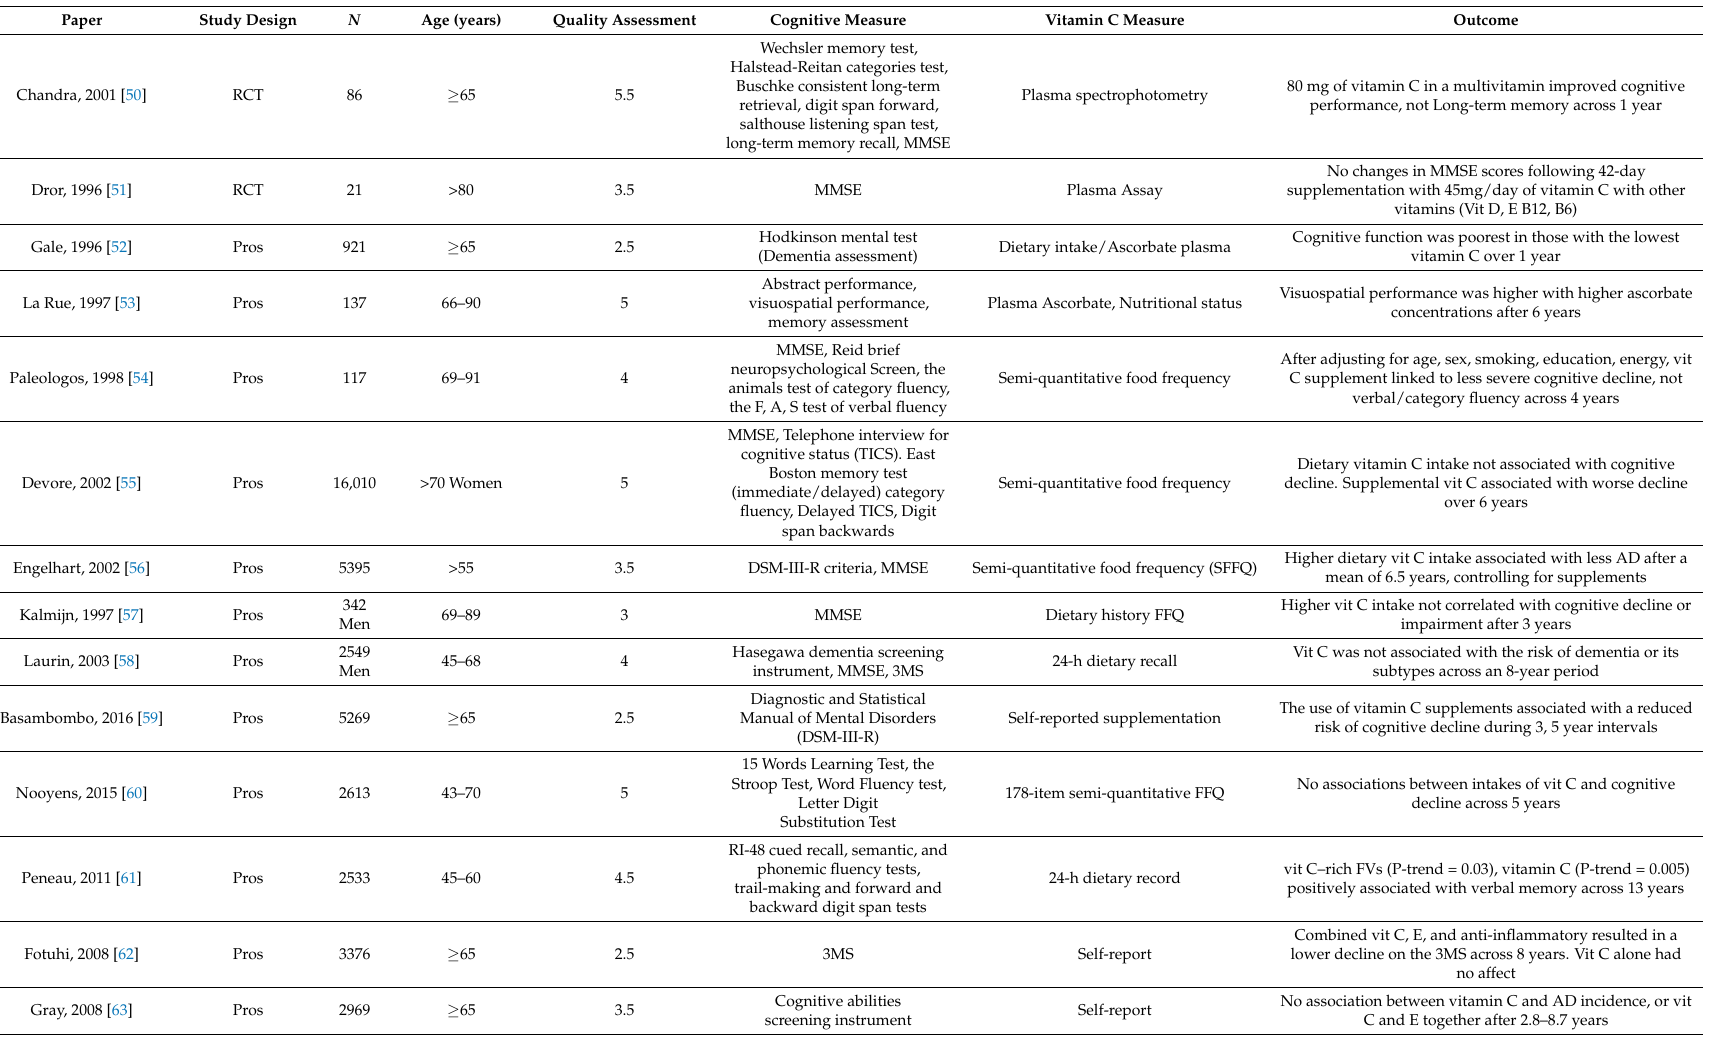
Table 2. Characteristics and outcomes of studies using cognitively intact